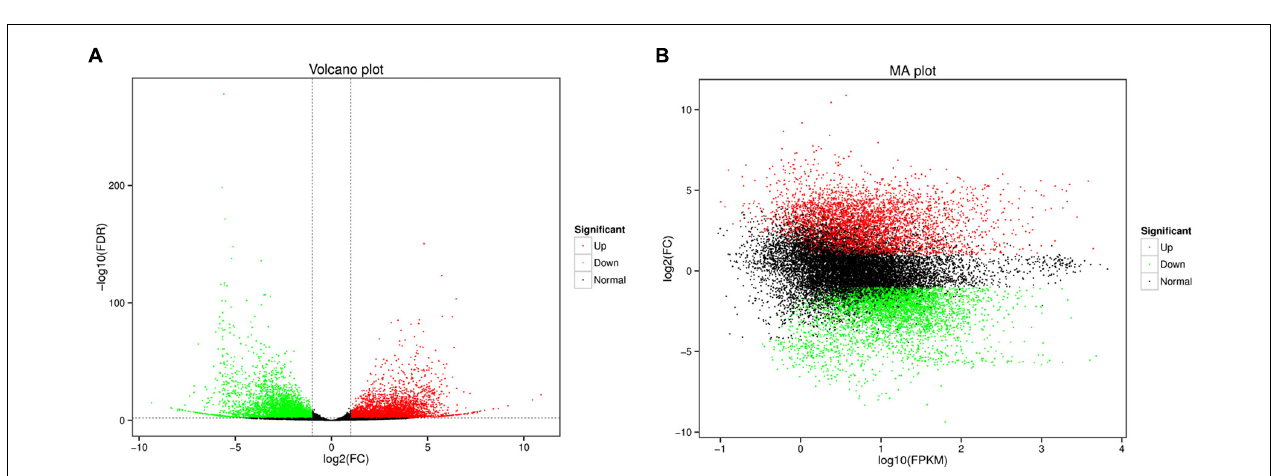
FIGURE 2 | Volcano plot (A) and MA plot (B) of DEGs (Green dots represented downregulated genes, the red dots represented upregulated